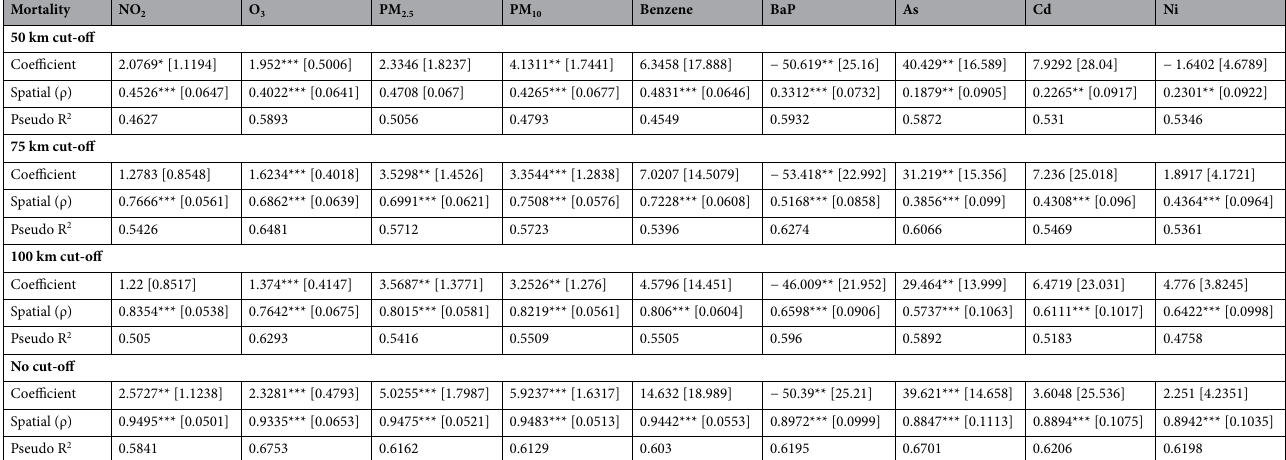
Table 12. Results from SAR models on COVID-19 excess mortality registered on 30 November 2020. p-value < 0.01***; p-value < 0.05**; p-value < 0.1*. Standard errors in parentheses. All models included a constant and the following controls: dummies for regional capitals and national borders, size of the province, population aged 0–19, distance from nearest airport, share of foreigners, share of male population, population density, degree of urbanization, deaths due to LRT disease, smokers, obese individuals, large firms, altitude, and rainy